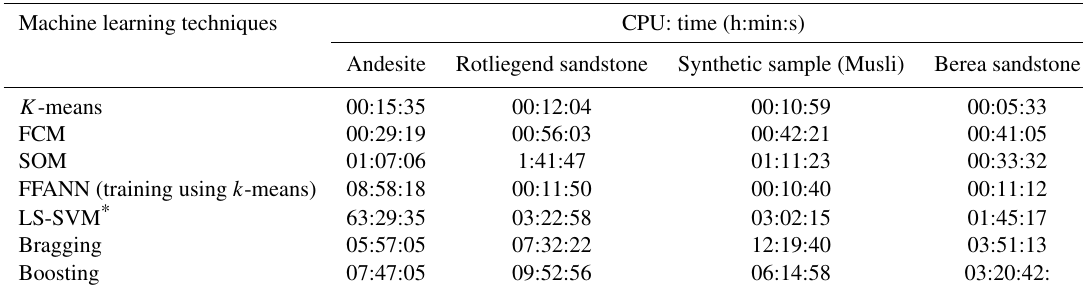
Table 2. The computational time for processing 10 slices. Machine learning techniques